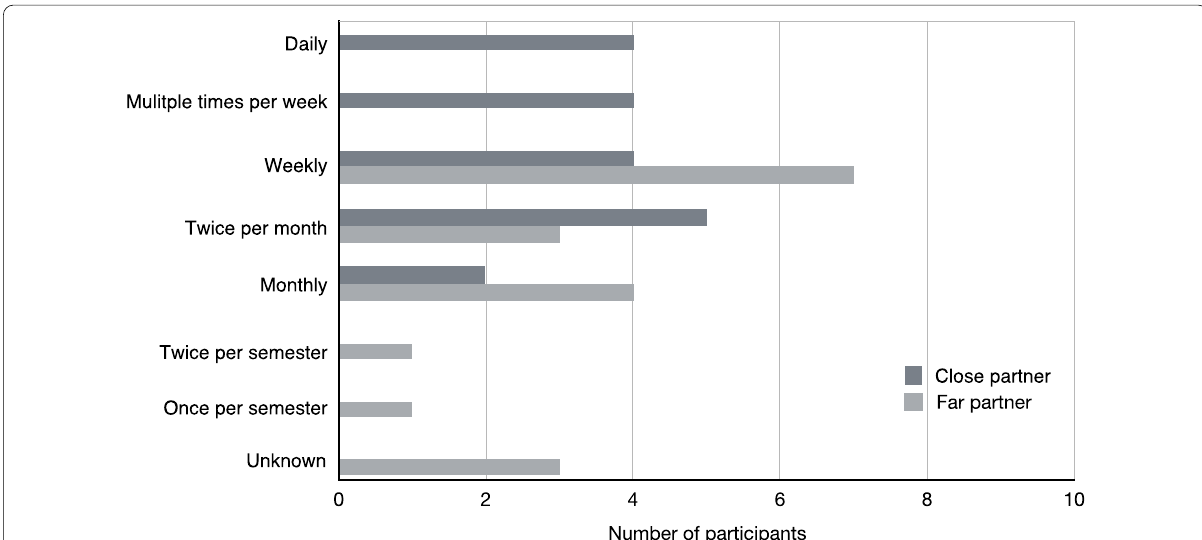
Fig. 2 Frequency of conversations between faculty and their selected discussion partners. Bars represent the number of interview participants ( n 19) whose interactions with close (dark gray) and far (light gray) partners fell into the given frequency =